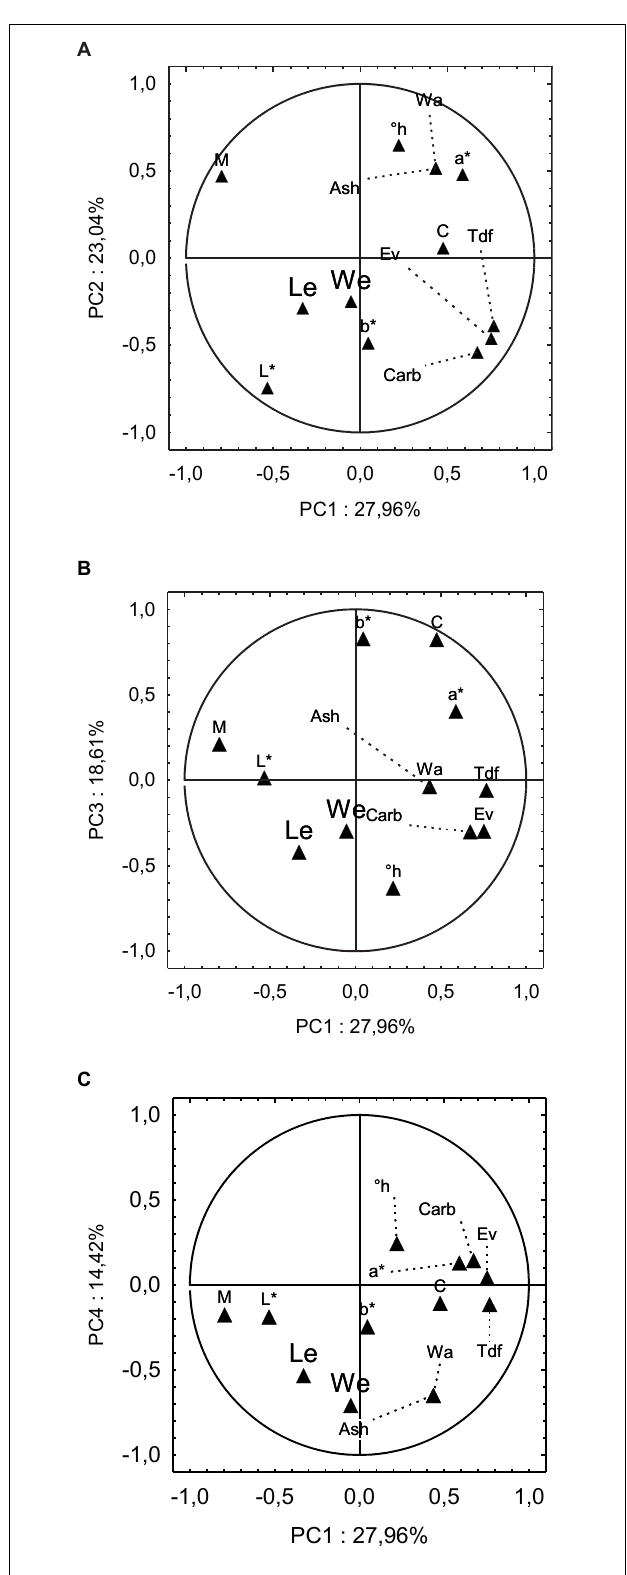
FIGURE 2 | Principal component analysis (PCA) distribution of independent variables: (A) PC1 × PC2, (B) PC1 × PC3, and (C) PC1 ×